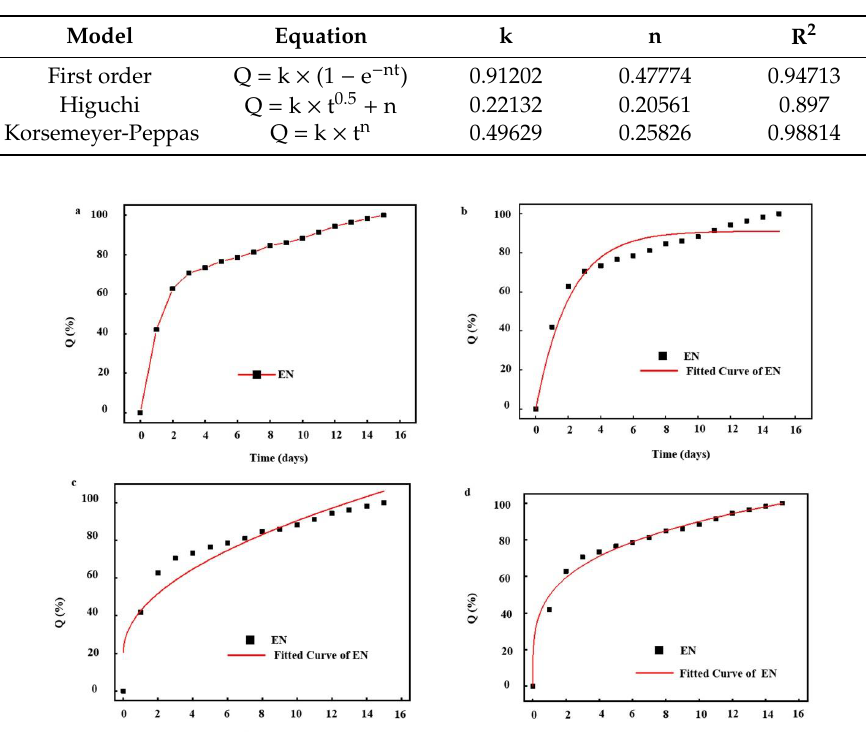
Figure 6. ( a ) Actual kinetic release profiles of nisin from nanofibers; the corresponding fitted curves following first order ( b ), Higuchi ( c ), and Korsemeyer–Peppas ( d ) models.